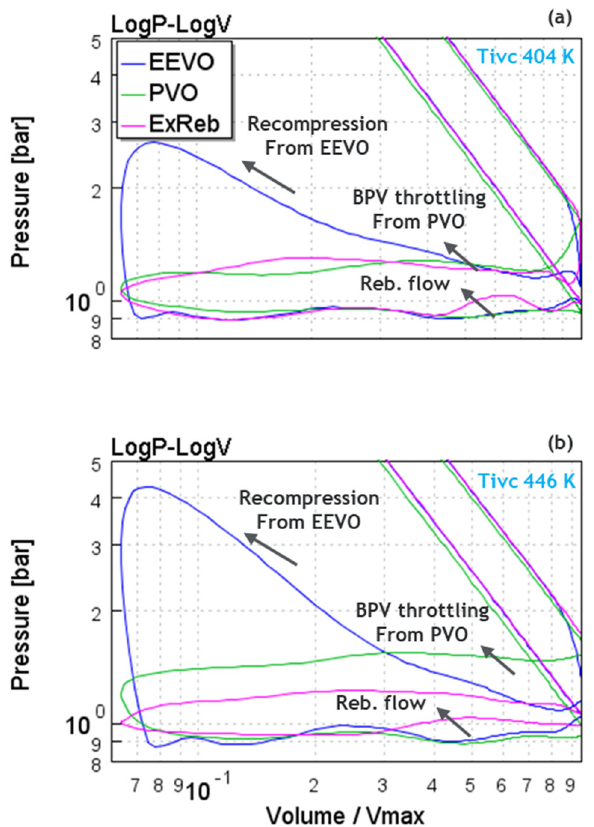
Figure 14. LogP-LogV trends at ( a ) Tivc 404 and ( b ) Tivc 446 K cases for the EEVO, PVO, and ExReb strategies.